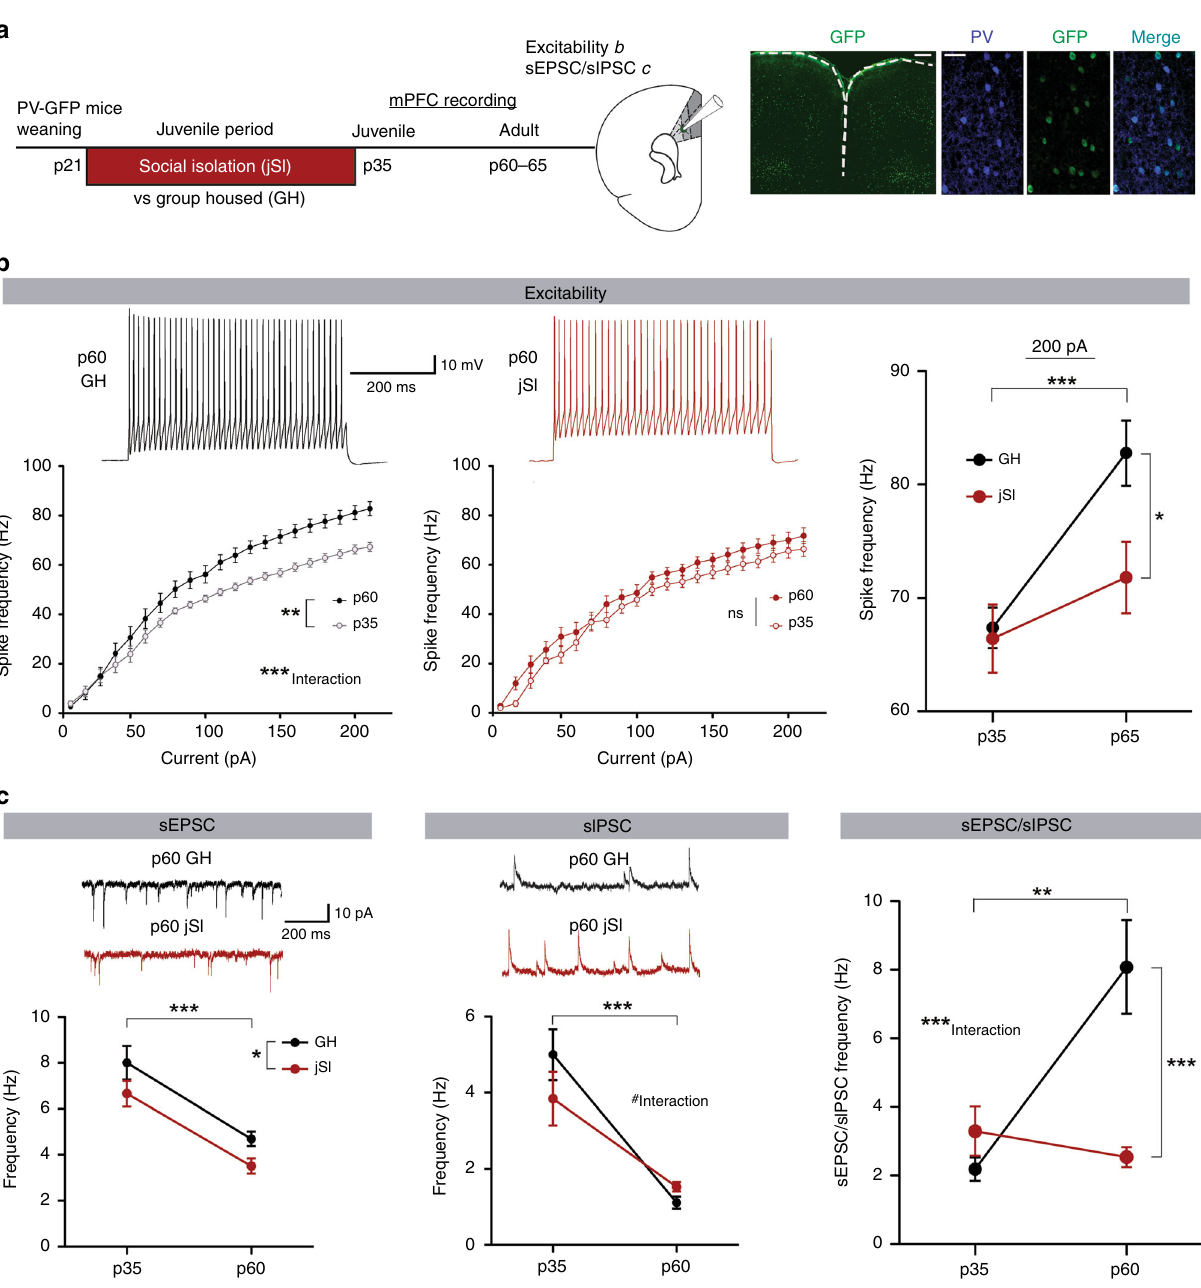
Fig. 5 Juvenile social isolation causes altered maturation of dmPFC PVIs, leading to long-lasting reduction of excitability and input drive of adult dmPFC PVIs. a Timeline of juvenile social isolation (jSI) or group housing (GH) followed by whole-cell patch clamp from dmPFC PVIs at p35 or adulthood (left). Right: GFP + cells (green) co-localize with PV + cells (blue). Scale bar: left: 300 μ m right 50 μ m. b Top: Intrinsic excitability of dmPFC PVIs. Representative traces, 200 pA.. Bottom left: adult GH mice showed increased spike frequency at higher current steps (two-way mixed ANOVA, Age factor, F(1,40) = 9.36, ** p = 0.0035, age x current F(20,40) = 5.91, *** p < 0.0001). (bottom, middle) In jSI mice, there were no developmental differences (two- way mixed ANOVA, age factor F(1,37) = 2.15, df = 1, p = 0.15, age x current F(20,37) = 0.73, df = 20, p = 0.7977). Right: At 200 pA, spike frequency was signi fi cantly lower only in adult jSI mice (two-way ANOVA, housing factor, F(1,77) = 4.53, * p = 0.04, age factor, F(1,77) = 13.75, *** p = 0.0004, Bonferroni post hoc tests p60: p < 0.05, p35: p > 0.05). n = 19 cells, four mice (p36, GH/jSI), 20 cells, fi ve mice (p60, jSI) and 23 cell fi ve mice (p60, GH). c Upper: representative postsynaptic current (PSC) traces. Lower left: sEPSC frequency signi fi cantly decreased across development and was lower in jSI (two-way ANOVA, age factor, F(1,81) = 43.75, *** p < 0.001, housing factor, F(1,81) = 6.68, * p = 0.01, p35 sEPSCs: n = 20 cells, fi ve mice (GH), n = 17 cells, fi ve mice (jSI), adult sEPSCs: n = 26 cells, seven mice (GH), 22 cells, six mice (jSI)). Lower middle: sIPSC frequency also decreased in adults; however, there was a trending interaction (two-way ANOVA, age factor, F(1,81) = 49.59, *** p < 0.0001, age x housing F(1,81) = 3.20, # p = 0.07, p35 sIPSCs: n = 20 cells, fi ve mice (GH), n = 17 cells, fi ve mice (jSI), adult sIPSCs: n = 26 cells, seven mice (GH), n = 22 cells, six mice (jSI)). Right: the developmental change of the sEPSC/sIPSC frequency ratio showed a strong interaction (two-way ANOVA, age x housing, F(1,81) = 13.06, *** p = 0.0005), indicating an absent developmental increase in jSI mice (Bonferroni post hoc test p60, *** p < 0.0001). Error bars re fl ect + / − SEM. Supplementary Fig. 15. Source data are available as a Source Data fi